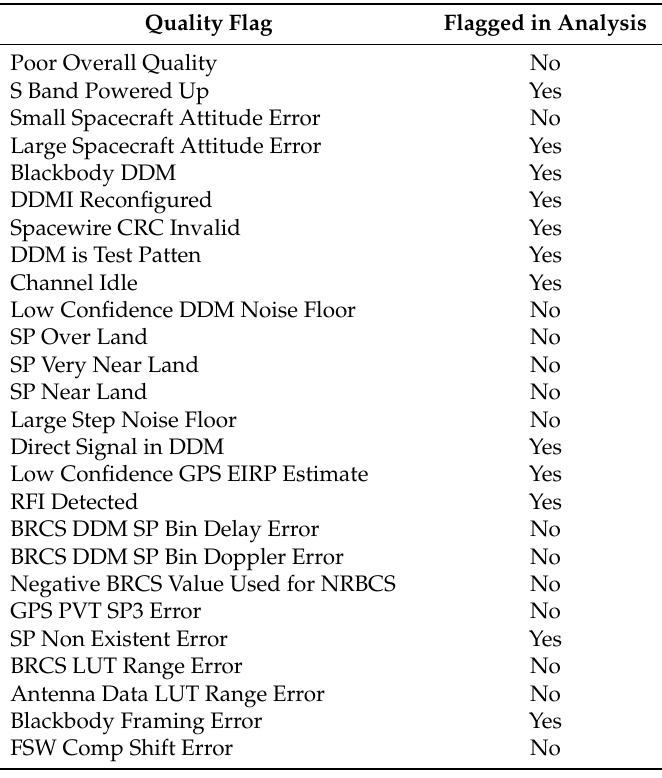
Table A1. CYGNSS L1 data quality flags used in this study [10]. Quality Flag Flagged in